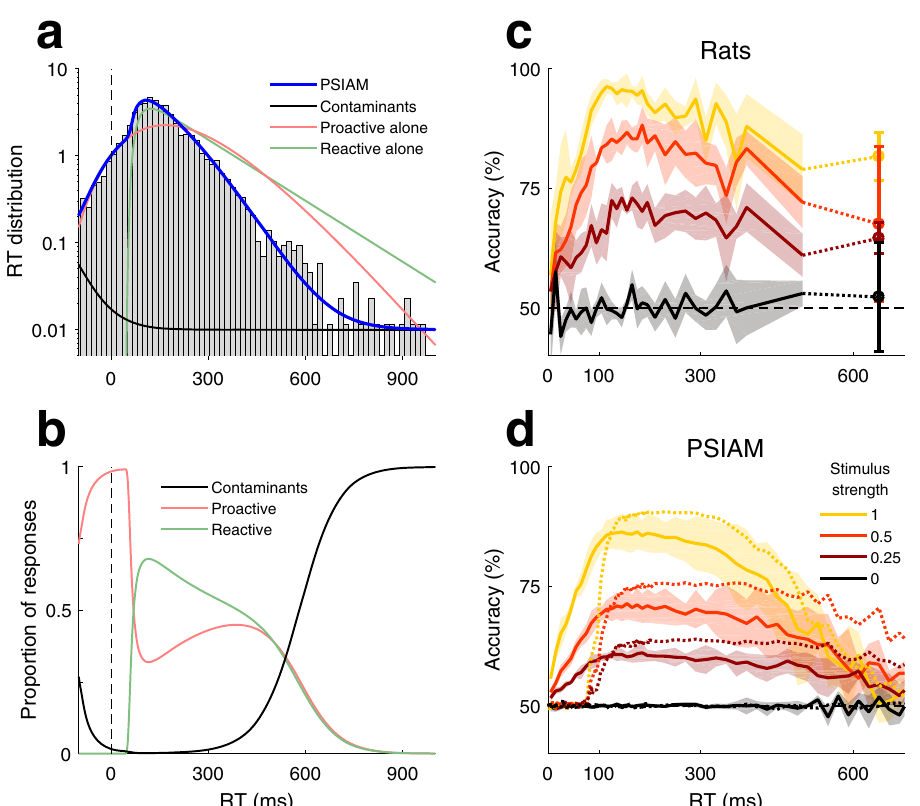
Fig. 4 Reaction times and accuracy for long responses. a RT distribution for an example animal (gray bars; rat #15) and model fi t (PSIAM, blue line) for medium stimulus strength ( s = 0.5). To better resolve the tail of the distribution we used a logarithmic scale. Notice how the tail of the PSIAM distribution has been substantially trimmed with respect to the distributions of proactive alone (red) and reactive alone (green) RTs generated by the AI and EA processes working in isolation. For very long RTs (above 600 ms), contaminant responses, modeled as random guesses, dominate the pdf (black curve; average 7 ± 3% of the total responses; see “ Methods ” and Supplementary Fig. 8). Distribution of contaminant RTs is shown in black. b Proportion of proactive (red), reactive (green) and contaminant (black) responses vs. RT for the same example rat as in panel ( a ). c Tachometric curves for different stimulus strength s values, median across rats. Open circles indicate accuracy for responses of RT > 600 ms. Shaded areas and error bars: median absolute deviation. d Simulated PSIAM tachometric curves up to 700 ms, median across rats; shaded areas: median absolute deviation. Simulations of the eDDM are also shown (dotted lines) to illustrate the decay in accuracy caused by contaminant responses only. Source data are provided as a Source data fi